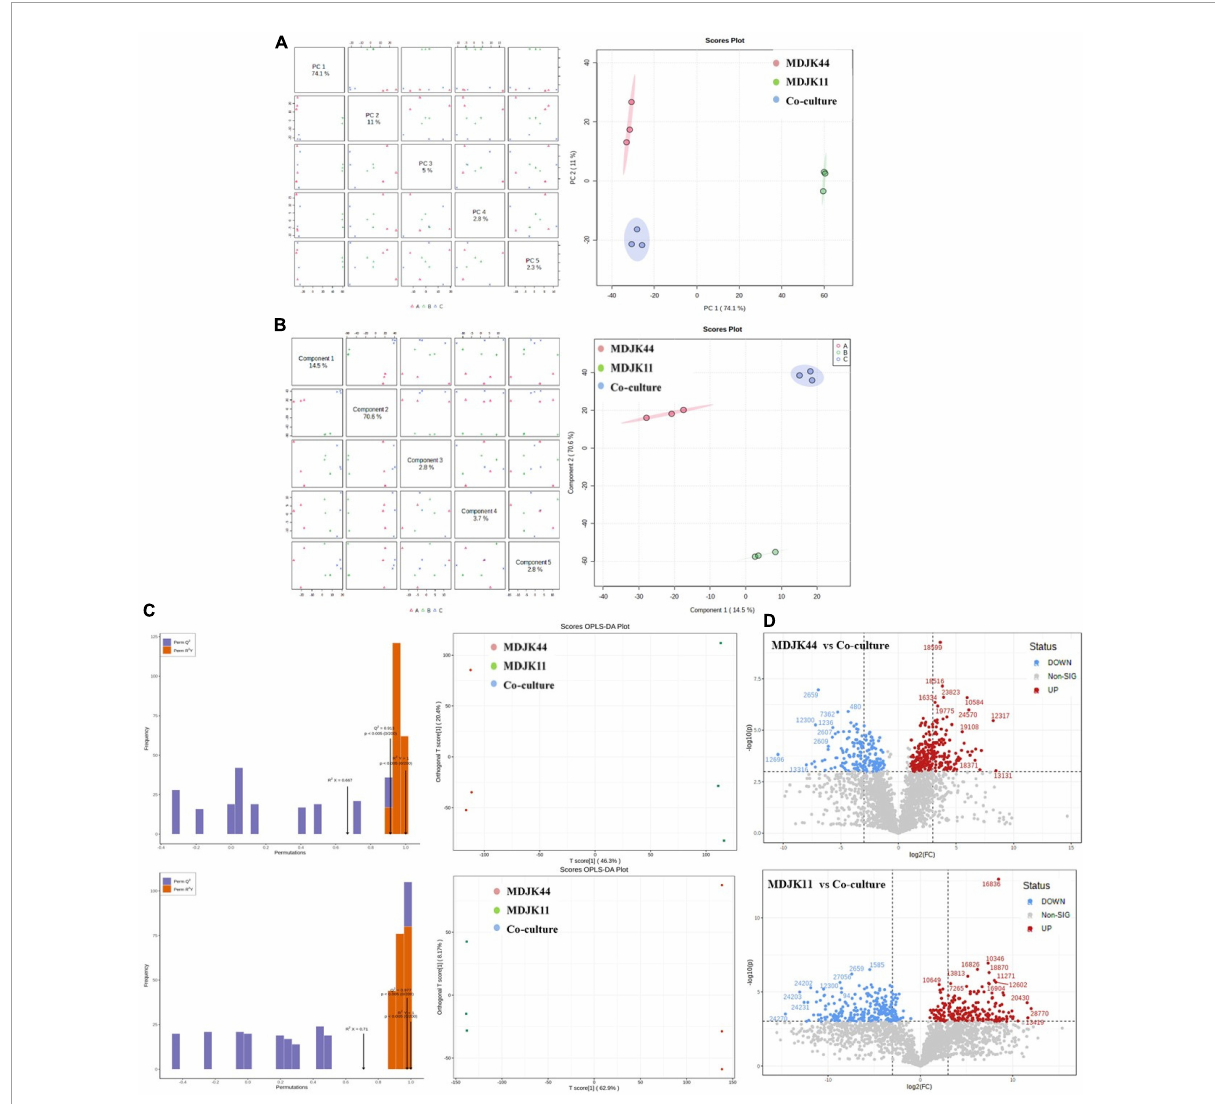
FIGURE9 Multivariate statistical analysis of Streptomyces MDJK11 and MDJK44 in monoculture and co-culture [ (A) , PCA scores graphs; (B) , PLS-DA graphs; (C) , Scores OPLS-DA plots; and (D) , differential metabolite volcano graphs].